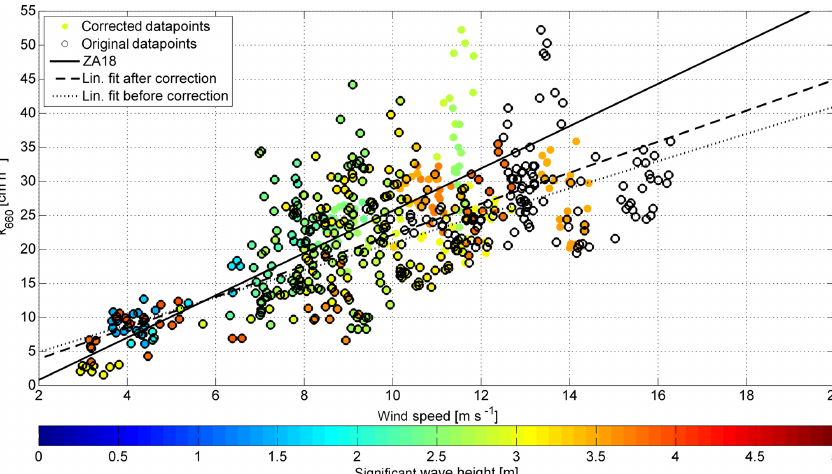
Figure 2. Adjustments to the SO234-2/235 DMS k vs. u relationship. The datapoints with | Re tr | ≺ 6 . 96 × 10 5 were adjusted using the gas transfer suppression model. Black circles denote k values at the original wind speed u 10 . Colored filled circles denote the k value at wind speed equals to u alt . The color shows the significant wave height. If a datapoint has a concentric black and filled circle, it was not adjusted, as it was not subject to gas transfer suppression. The black solid line is the ZA18 parameterization. The dotted line is the linear fit to the datapoints before the adjustment; the dashed line is the linear fit after the